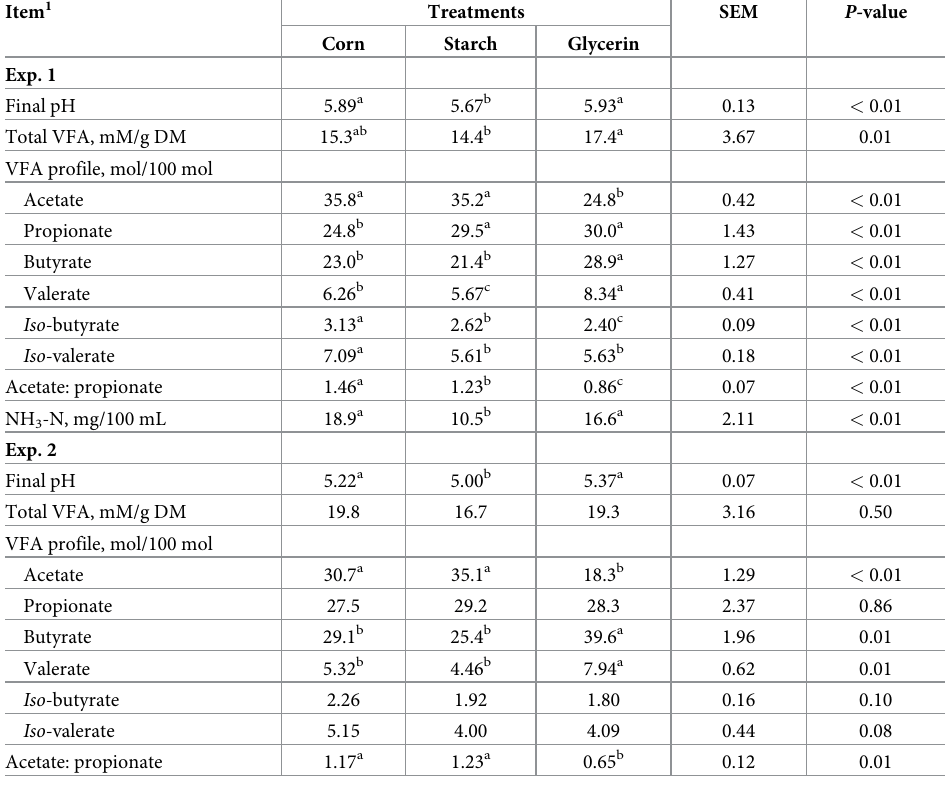
Table 3. Effects of different ingredients on ruminal variables in gas production systems. Item 1 Treatments SEM P -value Corn